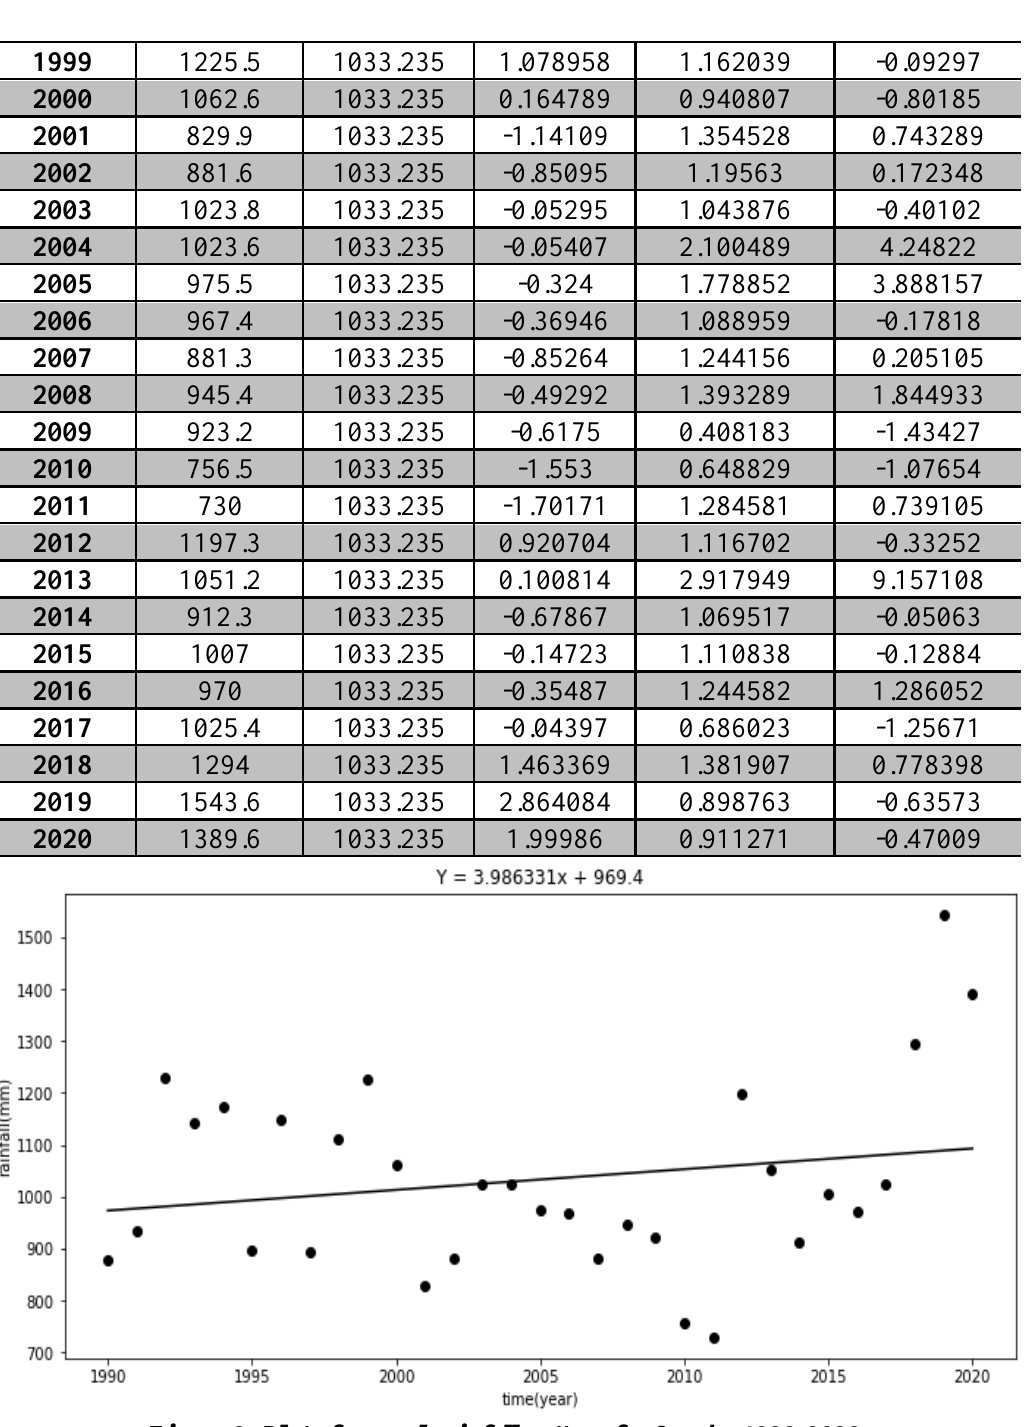
Figure 2: Plot of annual rainfall pattern for Gombe